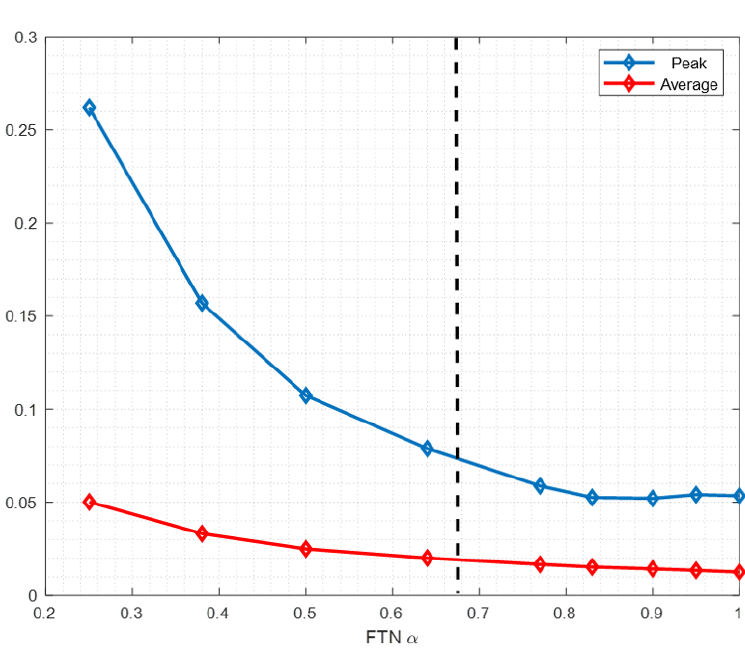
Figure 10. Comparison of peak and average value of FTN under different acceleration factor α .